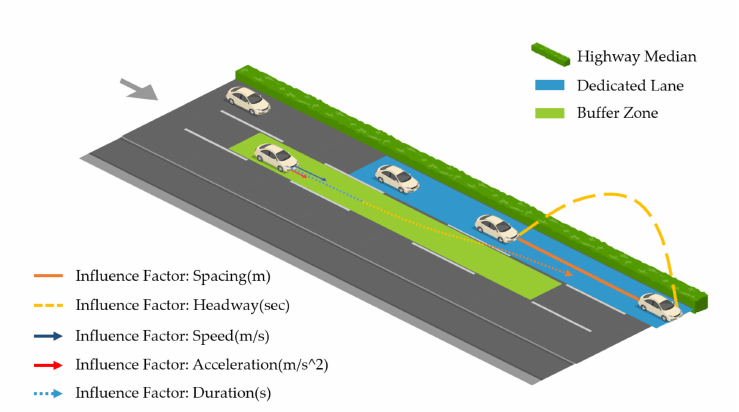
Figure 6. The influencing factors of the lane-changing